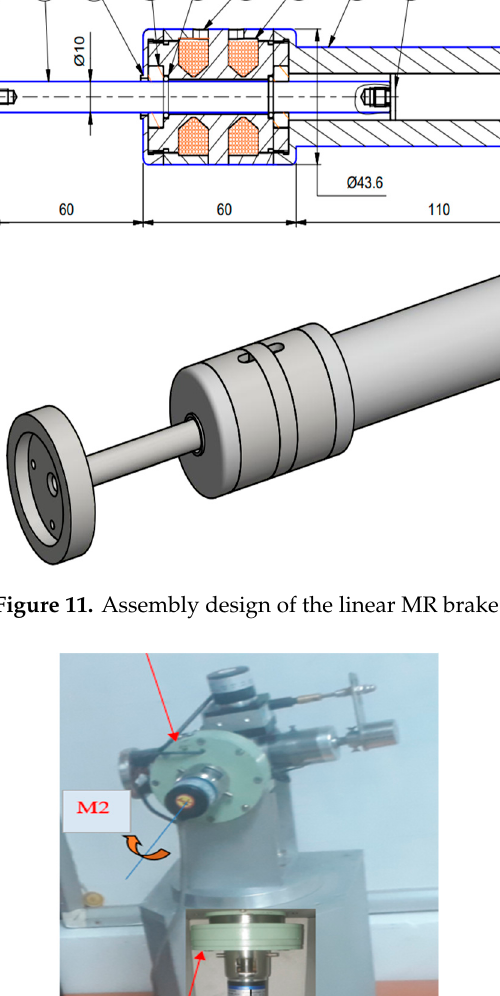
Figure 12. The 3-DOF spherical force feedback prototype.